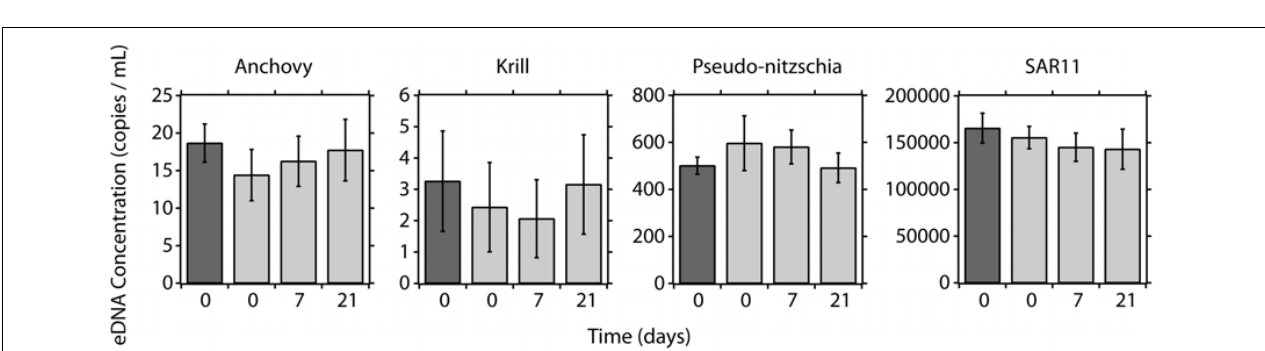
FIGURE 4 | Log-log correlation of eDNA recovery collected via the traditional laboratory method ( x -axis) and using the benchtop-ESP and the LRAUV-ESP methods ( y -axis). Filled symbols are the direct comparisons (same water, benchtop-ESP vs. traditional method) and open symbols are the indirect collection method comparisons (LRAUV-ESP vs. ship-based collection with the traditional peristaltic method). Error bars represent 95% confidence intervals.